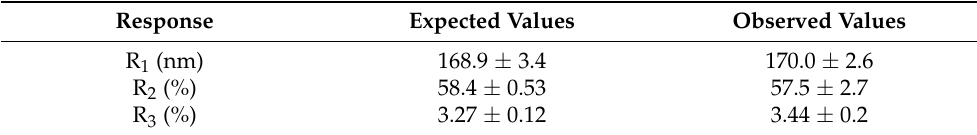
Figure 4. Optimization ramp for the investigated independent variables, ( A ) oil concentration; ( B ) EPC concentration, along with their expected values of responses; ( C ) particle size; ( D ) in vitro release; ( E ) hemolysis, in addition to the desirability value. Table 5. Expected and observed values of the optimized PX-NE formulation .